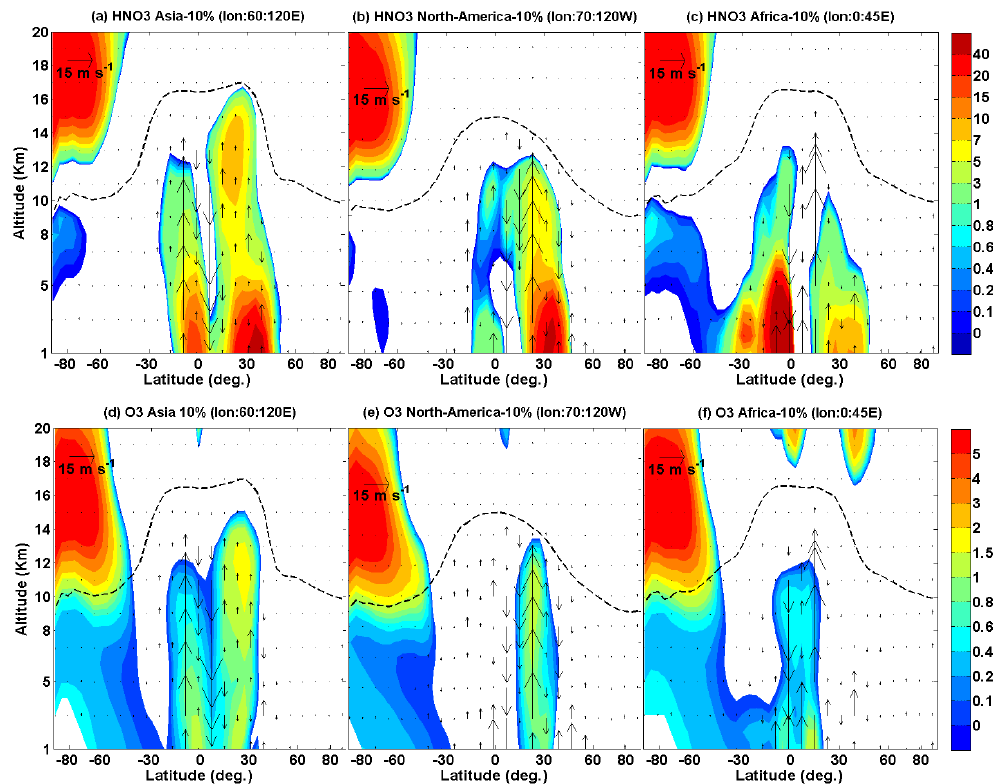
Figure 9. Latitude–altitude variation of (a) HNO 3 (reference–Asia − 10%), averaged over 60–120 ◦ E (b) HNO 3 (difference of reference– North America − 10%), averaged over 70–120 ◦ W (c) HNO 3 (reference–Africa − 10%), averaged over 0–45 ◦ E (d) O 3 (difference of reference–Asia − 10%) averaged over 60–120 ◦ E (e) O 3 (reference–North America − 10%) over North America averaged over 70–120 ◦ W (f) O 3 (reference–Africa − 10%) over Africa averaged over 0–45(reference–Africa − 10%). HNO 3 is expressed in ppt and ozone in